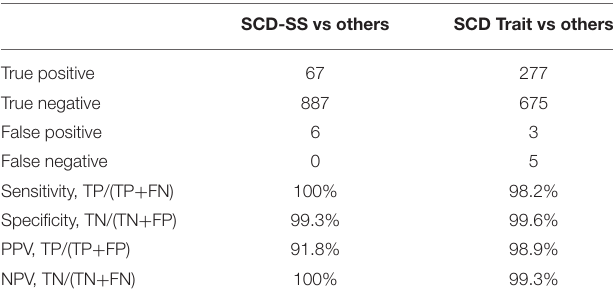
TABLE 3 | Gazelle diagnostic sensitivity, specificity, positive predictive value (PPV), and negative predictive value (NPV) in comparison to reference standard